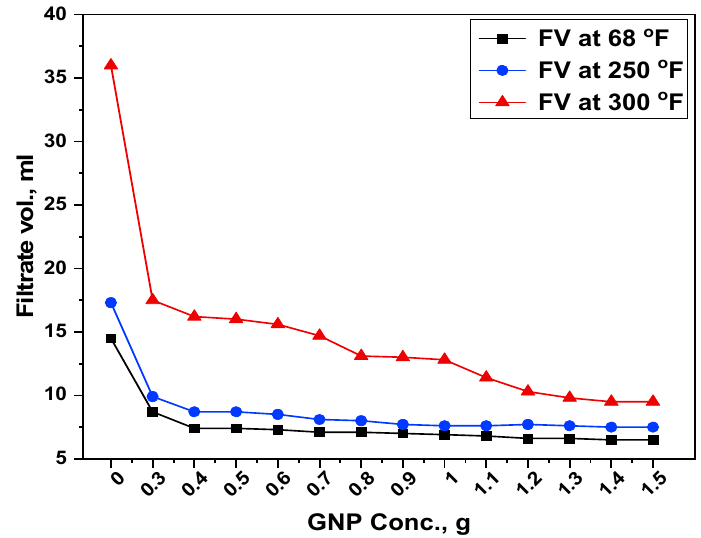
Figure 7. Filtrate volume of formulated mud at ambient and high temperatures.